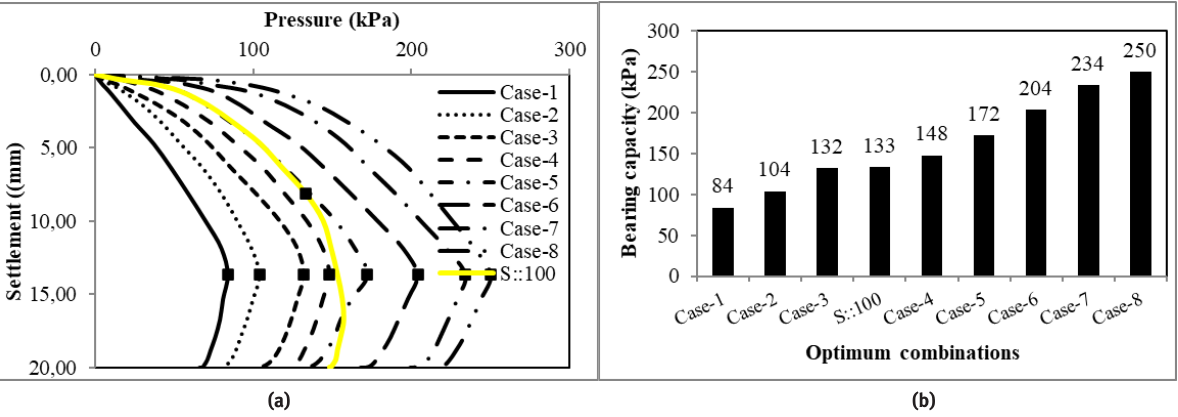
Figure 12: (a) Pressure–settlement curves and (b) bearing capacity values of two-layered soil for all cases at h/B=2.275 and single-layer sandy soil for